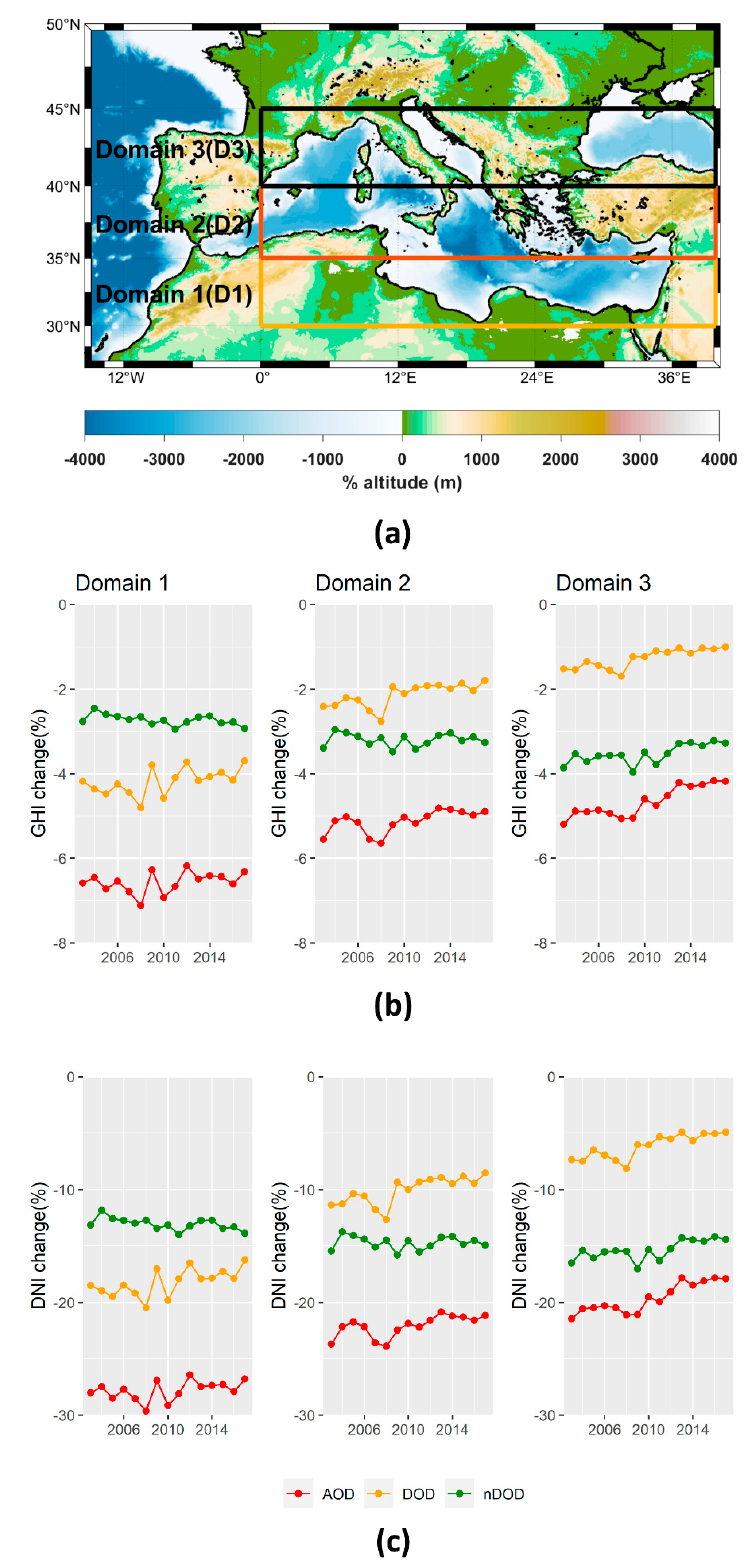
Figure 12. ( a ) The geographical limits of the domains used for the spatial averaging. Interannual variability of GHI ( b ) and DNI ( c ) annual integral change (in %) by total aerosols (AOD, red line), dust (DOD, blue line) and other aerosol components beside dust (nDOD, green line) regional averaged for domains 1, 2 and 3 for the 15-year period